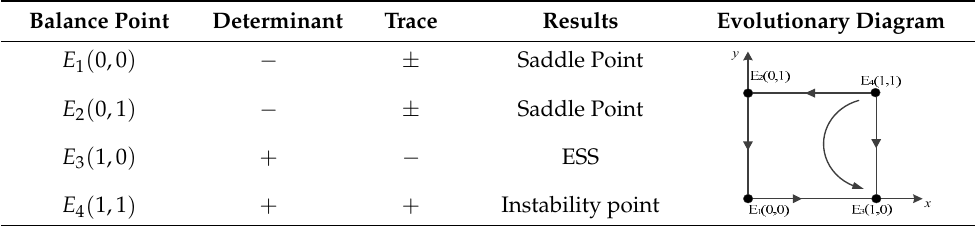
Table 5. Scenario 2 evolutionary game model steady state analysis. Balance Point Determinant Trace Results Evolutionary Diagram Balance Point Saddle Point